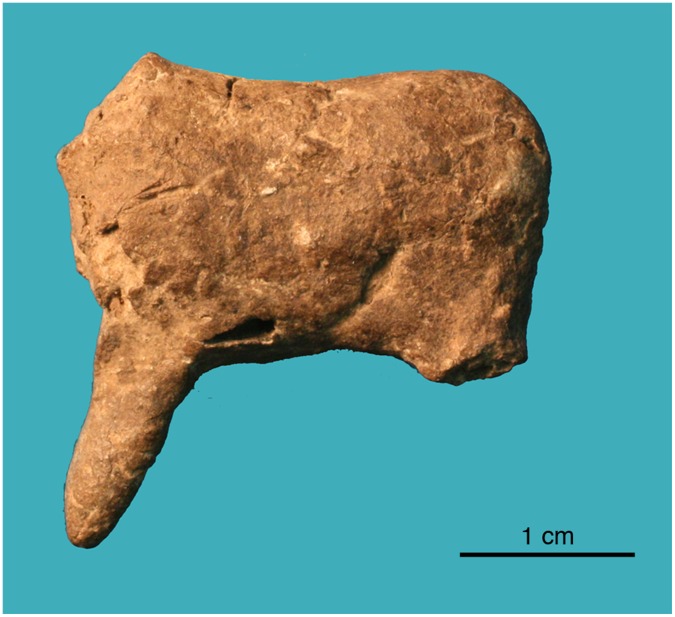
Photograph of C1.